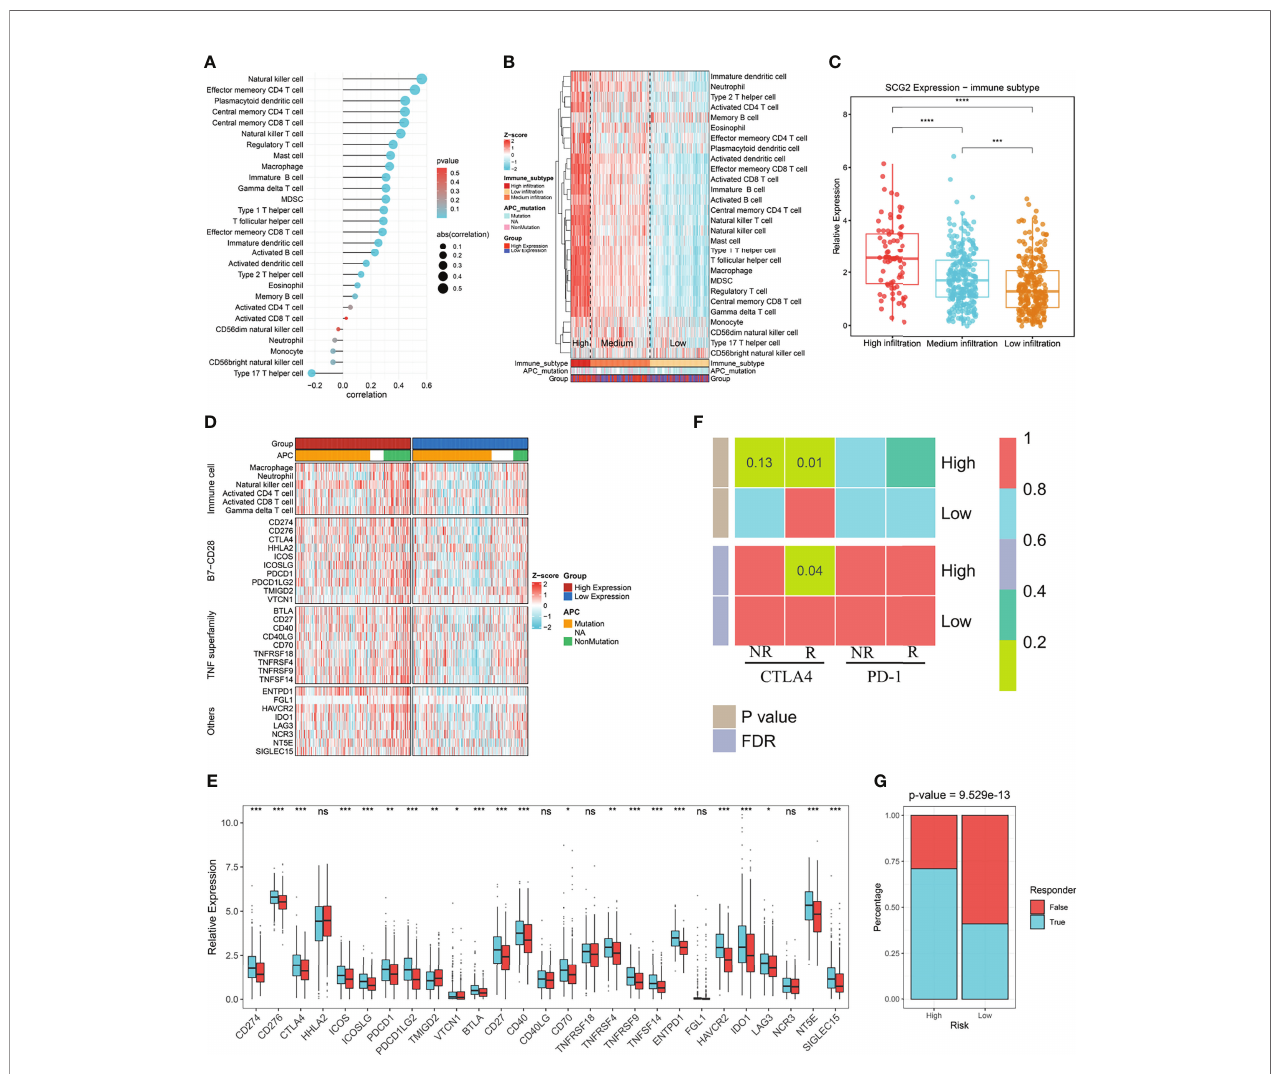
FIGURE 8 | Immune in fi ltration associated with SCG2 expression and immunotherapy prognosis. (A) Correlation of immune cell in fi ltration score with SCG2 expression. (B) Distribution of immune cell in fi ltration and clinical features among the three subtypes obtained by hierarchical clustering. (C) Signi fi cant differences in SCG2 expression among the three immune subtypes. (D) Differential expression analysis of molecules representing immune characteristics in different SCG2 expression subgroups. (E) Differences in immune checkpoint expression between high and low SCG2 expression groups. (F) SubMap algorithm evaluated the expression similarity between the two SCG2 expression subgroups and the patients with a different immunotherapy response. (G) Distribution of immunotherapy responders predicted by TIDE algorithm between high and low SCG2 expression groups. * P <0.05; ** P <0.01; *** P <0.001; **** P <0.0001; ns, P